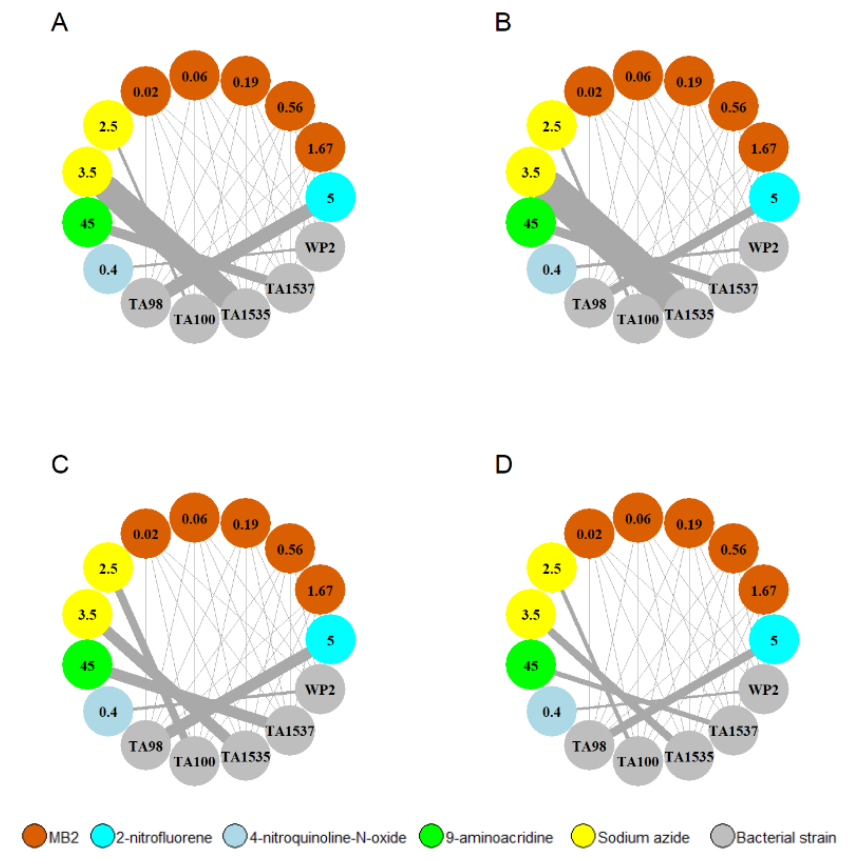
Figure 9. Genotoxic effects of MB2 using Ames assay. Different strains of S. typhimurium (TA98 and TA100), E. Coli (WP2) and S. typhimurium (TA1535 and TA1537) were tested by: ( A ) direct incorporation procedure without metabolic activation; ( B ) pre-incubation procedure without metabolic activation; ( C ) direct incorporation procedure with metabolic activation; ( D ) pre-incubation procedure with metabolic activation. The representation reflects the amount (mg/plate) of each compound (MB2, 2-nitrofluorene, 4-nitroquinoline-N-oxide, 9-aminoacridine, and sodium azide) in each sphere, while the connection lines width are proportionally direct to the ratio of revertant colonies per ex- posed plate (R). Ratio value (R) was obtained by comparison between the triplicate count mean of DMSO control solvent and the triplicate count mean of each concentration of compound